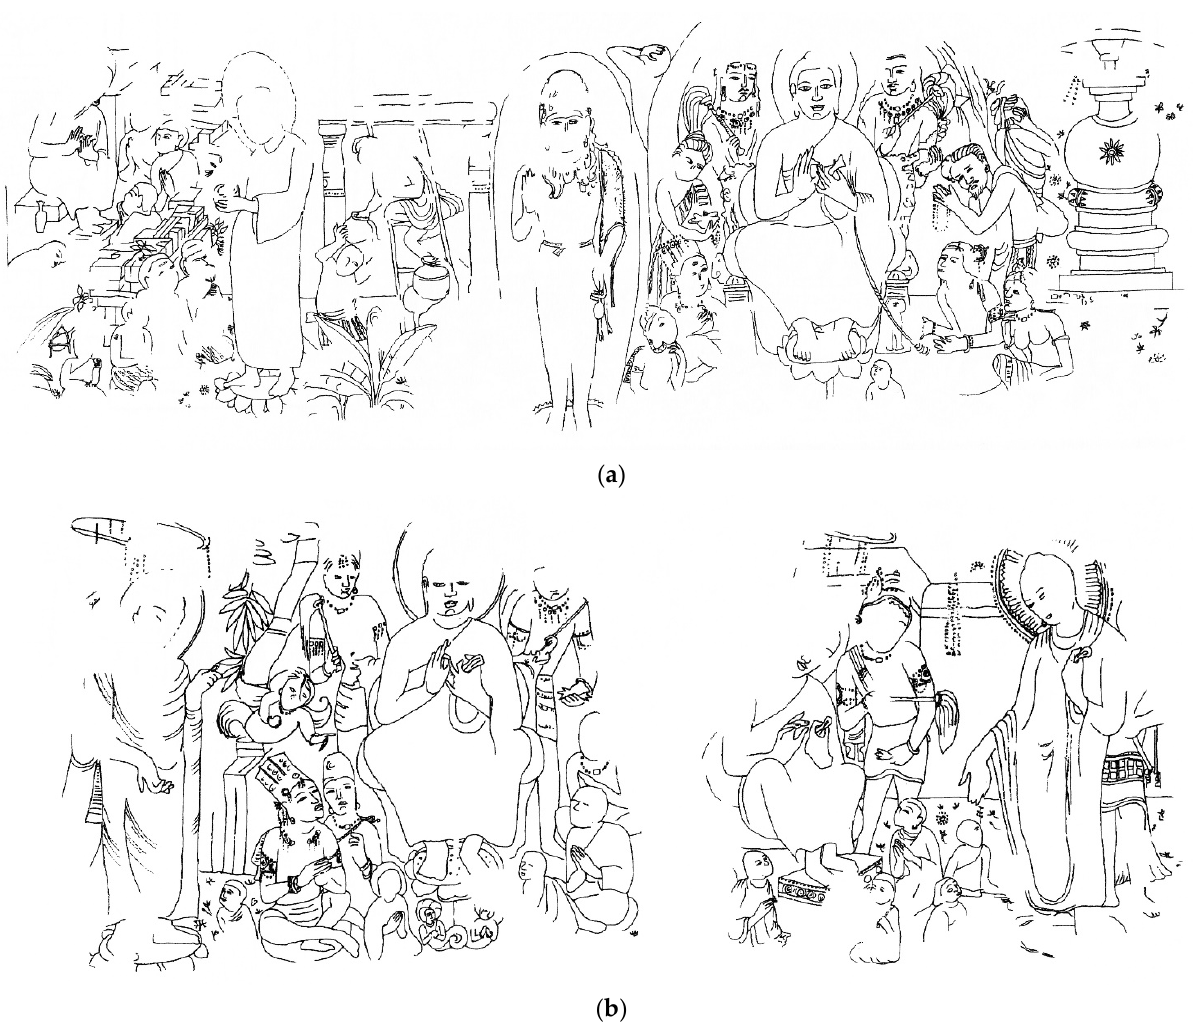
Figure 1. ( a ) Line drawing of a mural painting (intrusive?) from the rear of Aja ṇṭ ā Cave 9 on the left side, possibly depicting episodes of the Lotus S ū tra , ca. 478–480 CE (Matthias Helmdach © Ajanta Archives of the Saxon Academy of Sciences and Humanities). ( b ) Line drawing of a mural painting (intrusive?) from the rear of Aja ṇṭ ā Cave 9 on the right side, possibly depicting episodes of the Lotus S ū tra , ca. 478–480 CE (Matthias Helmdach © Ajanta Archives of the Saxon Academy of Sciences and Humanities).